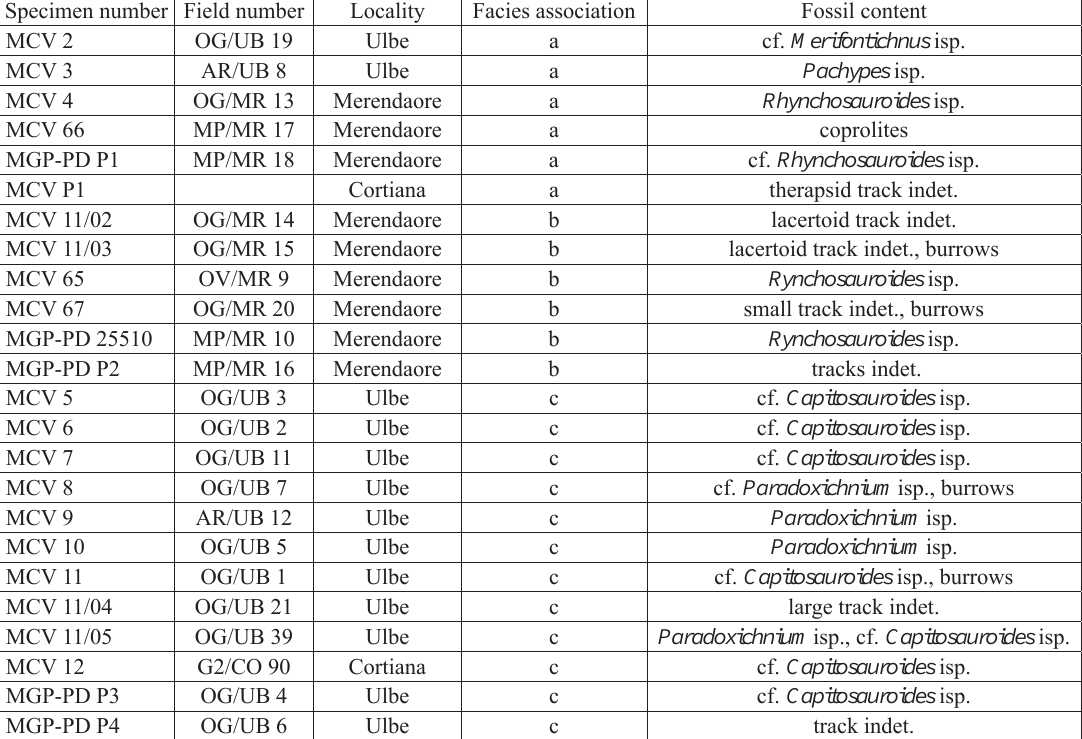
Table 1. Specimen list from the Recoaro area, with determination, locality and facies association. Specimen number Field number